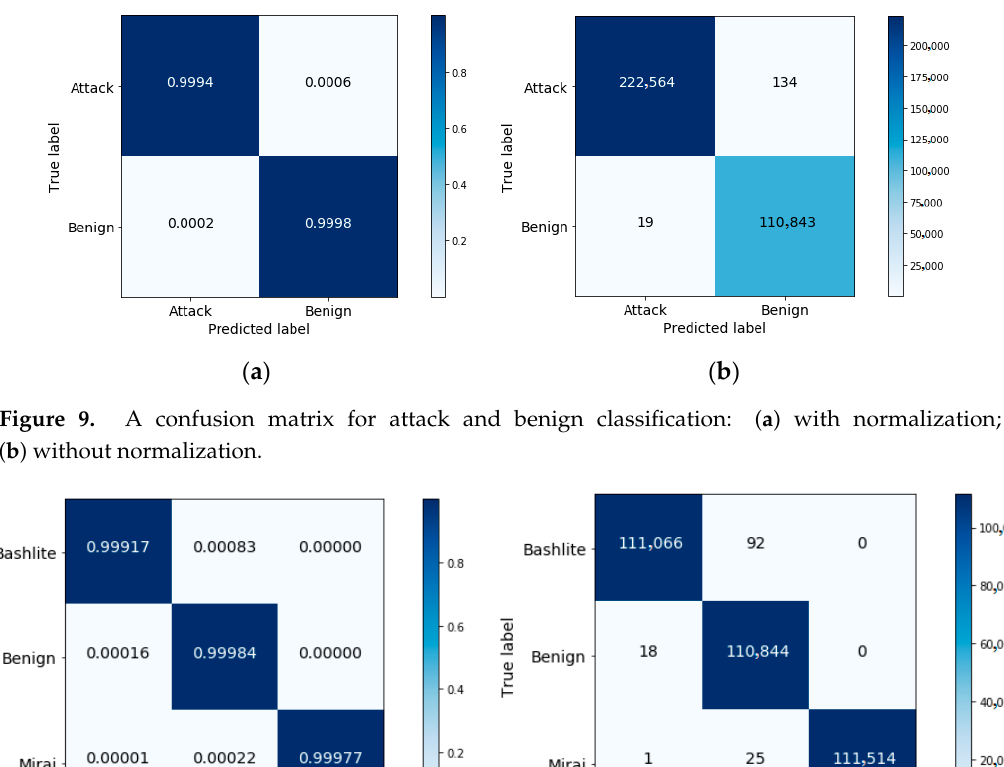
Bashlite, and benign classes.